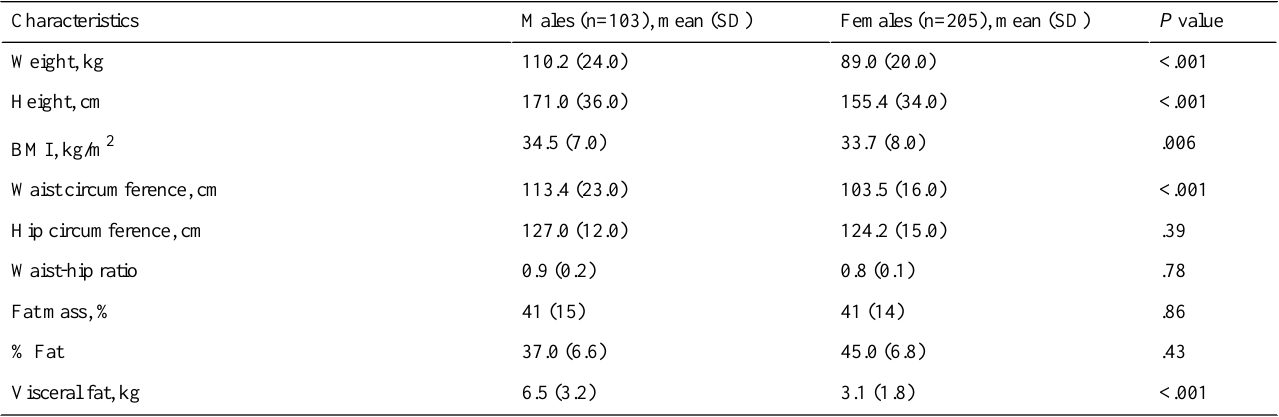
Table 3. Gender-specific anthropometric characteristics of patients